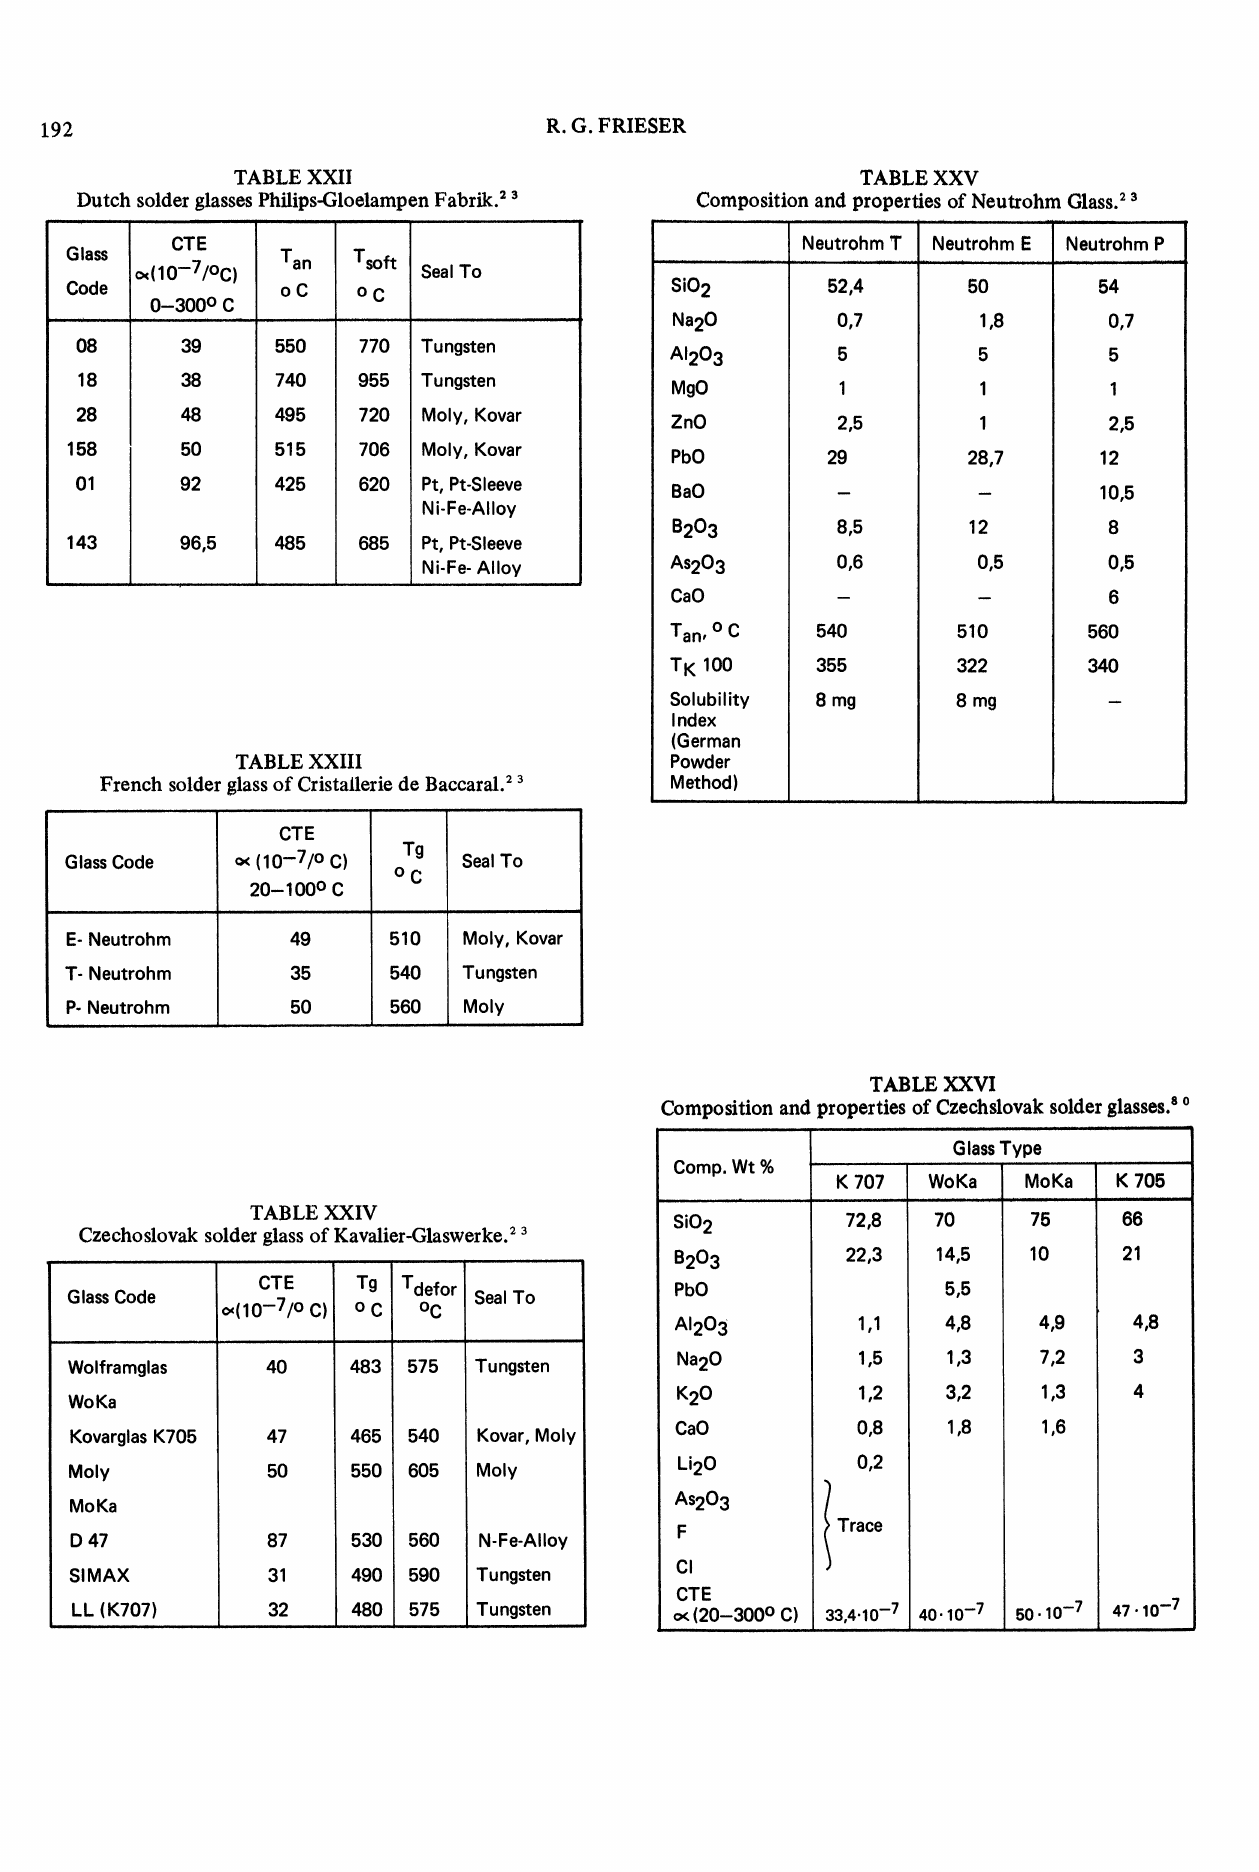
TABLE XXV Composition and properties of Neutrohm Glass.